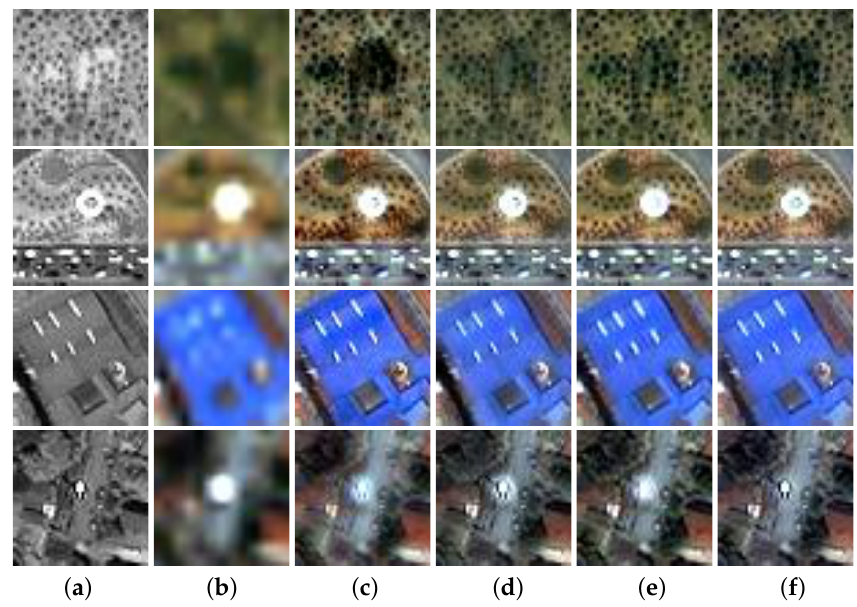
Figure 4. Visualization of IKONOS test image: ( a ) PAN; ( b ) MS; ( c ) BDSD; ( d ) MTF-GLP-HPM-PP; ( e ) PanNet; ( f ) PDSDNet.